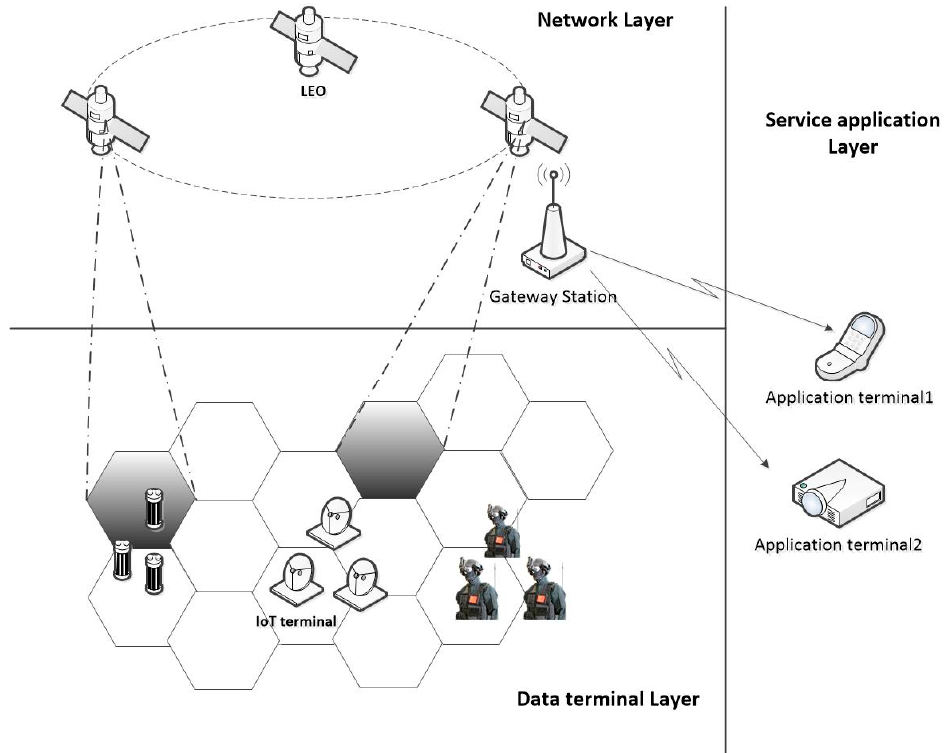
Figure 3. The architecture of Low-orbit satellite IoT with beam-hopping. The low-orbit satellite IoT system depicted in Figure 2 is divided into the network layer, data terminal layer and service application layer. Among them, the network layer